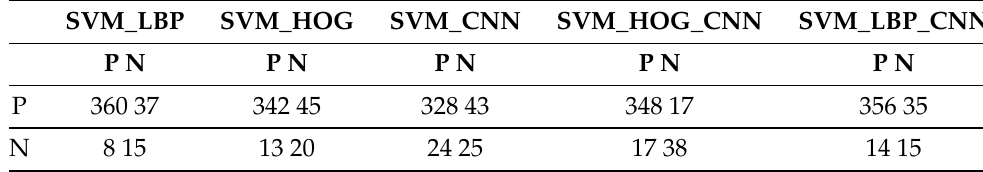
Table 5. Confusion Matrix for SVM with other Feature Descriptors.